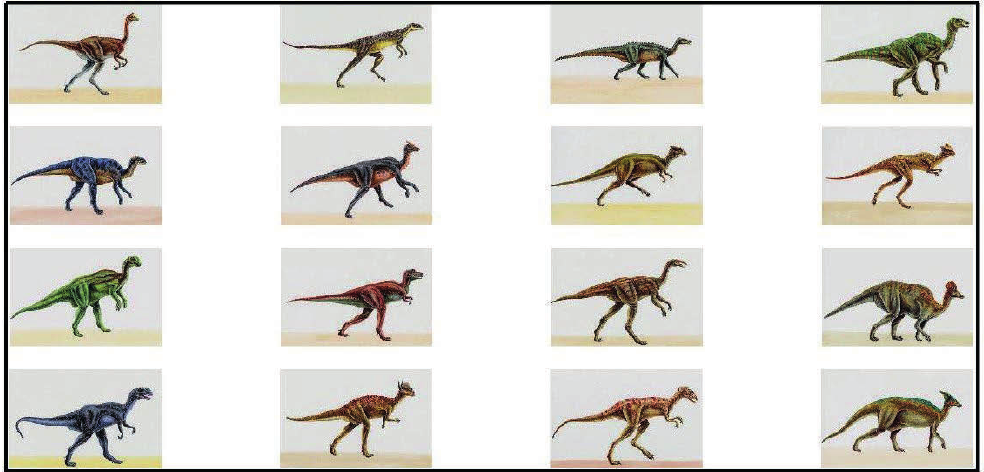
Fig. 12. Dinosaur images retrieved using Framework-2